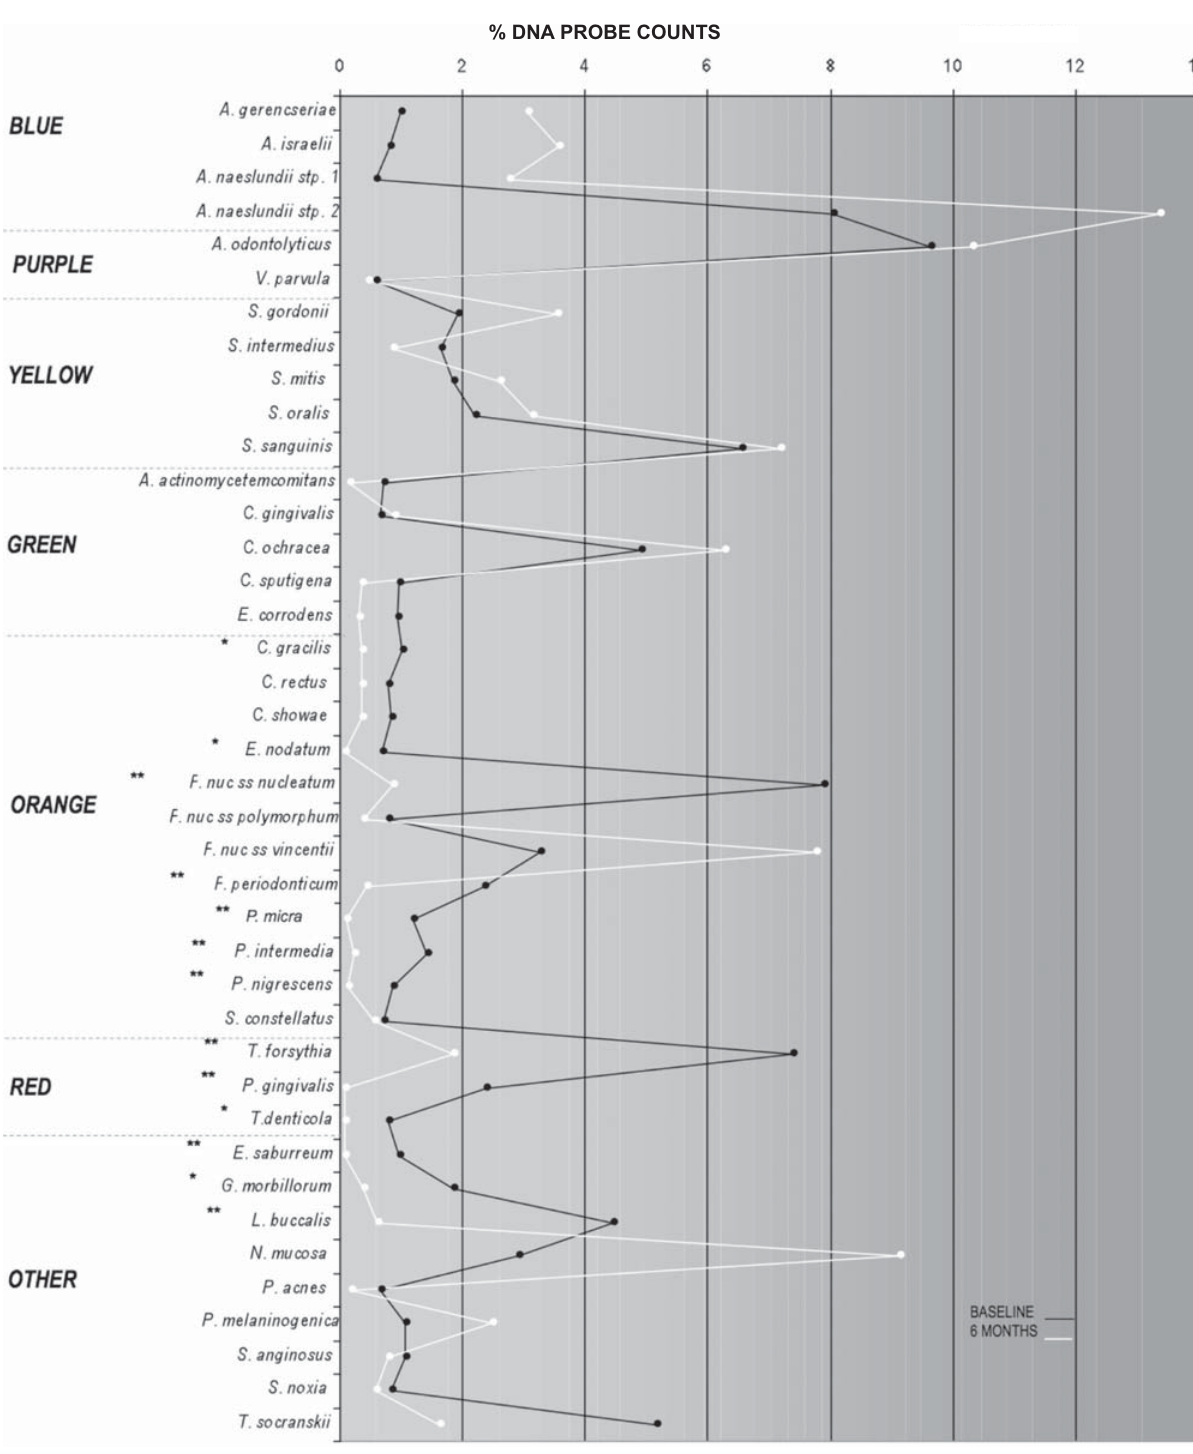
Figure 2- (cid:7)$(cid:5)(cid:2)(cid:10)(cid:7)(cid:13)(cid:6)(cid:9)(cid:13)(cid:9)(cid:6)(cid:4)(cid:15)(cid:9)(cid:10)(cid:14)(cid:7)(cid:9)(cid:3)(cid:7)%&(cid:7)(cid:14)(cid:29)(cid:30)(cid:18)(cid:15)(cid:10)(cid:18)(cid:15)’(cid:2)(cid:11)(cid:7)(cid:30)(cid:2)(cid:8)(cid:4)(cid:5)(cid:6)(cid:15)(cid:2)(cid:11)(cid:7)(cid:14)(cid:13)(cid:5)(cid:8)(cid:15)(cid:5)(cid:14)(cid:7)(cid:2)(cid:4)(cid:7)(cid:30)(cid:2)(cid:14)(cid:5)(cid:11)(cid:15)(cid:10)(cid:5)(cid:7)(cid:2)(cid:10)(cid:16)(cid:7)(cid:2)(cid:4)(cid:7)*(cid:7)(cid:27)(cid:9)(cid:10)(cid:4)!(cid:14)(cid:7)(cid:2)(cid:3)(cid:4)(cid:5)(cid:6)(cid:7)(cid:8)(cid:9)(cid:6)(cid:9)(cid:10)(cid:2)(cid:11)(cid:11)(cid:12)(cid:7)(cid:13)(cid:9)(cid:14)(cid:15)(cid:4)(cid:15)(cid:9)(cid:10)(cid:5)(cid:16)(cid:7)(cid:17)(cid:2)(cid:13)<(cid:7) (cid:24)!(cid:5)(cid:7)(cid:14)(cid:15)(cid:18)(cid:10)(cid:15)(cid:19)(cid:8)(cid:2)(cid:10)(cid:8)(cid:5)(cid:7)(cid:9)(cid:3)(cid:7)(cid:16)(cid:15)(cid:3)(cid:3)(cid:5)(cid:6)(cid:5)(cid:10)(cid:8)(cid:5)(cid:14)(cid:7)(cid:15)(cid:10)(cid:7)(cid:27)(cid:5)(cid:2)(cid:10)(cid:7)(cid:13)(cid:6)(cid:9)(cid:13)(cid:9)(cid:6)(cid:4)(cid:15)(cid:9)(cid:10)(cid:14)(cid:7)(cid:30)(cid:5)(cid:4)(cid:26)(cid:5)(cid:5)(cid:10)(cid:7)(cid:30)(cid:2)(cid:14)(cid:5)(cid:11)(cid:15)(cid:10)(cid:5)(cid:7)(cid:2)(cid:10)(cid:16)(cid:7)*(cid:7)(cid:27)(cid:9)(cid:10)(cid:4)!(cid:14)(cid:7)(cid:3)(cid:9)(cid:6)(cid:7)(cid:5)(cid:2)(cid:8)!(cid:7)(cid:14)(cid:13)(cid:5)(cid:8)(cid:15)(cid:5)(cid:14)(cid:7)(cid:26)(cid:2)(cid:14)(cid:7)(cid:4)(cid:5)(cid:14)(cid:4)(cid:5)(cid:16)(cid:7)(cid:29)(cid:14)(cid:15)(cid:10)(cid:18)(cid:7)(cid:4)!(cid:5)(cid:7) Wilcoxon signed-rank test after adjusting for multiple comparisons (*=p<0.05, **=p<0.01). The black line represents the mean data at baseline and the white line represents the mean data at 6 months